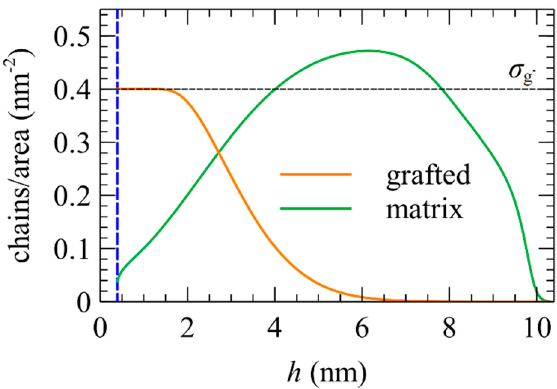
Figure 11. Chains/area profile from a GMV system of a perfectly wetted SiO 2 /PS GMV system (see Table 1 in Ref. [27]) with σ g − = 0.4 nm –2 , N g − = 50, N m = 100, and L = 10 nm.